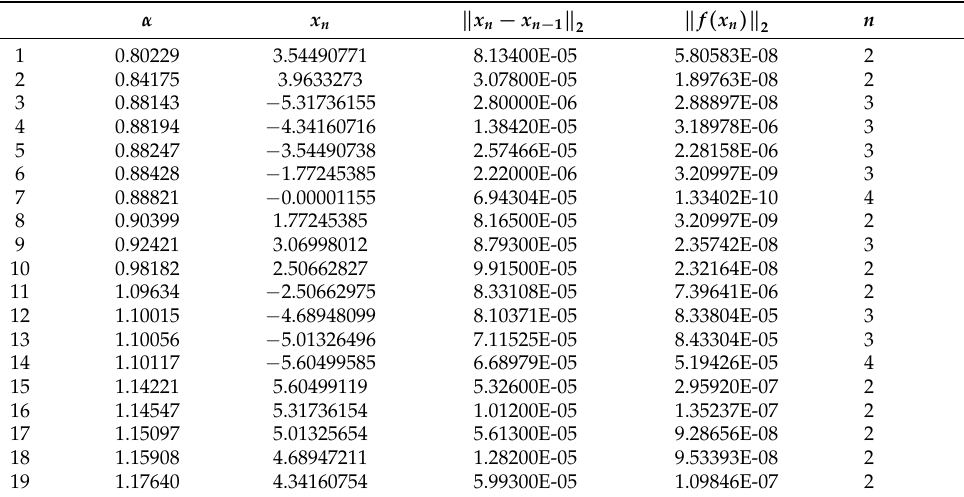
Table 8. Results obtained using the iterative method